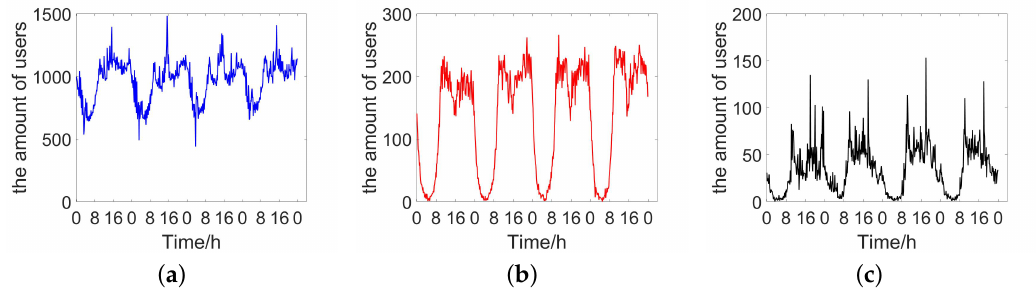
Figure 2. The amount of users extracted from three types datasets in a sample region. ( a ) The amount of users extracted from the mobility management signals in a sampl region; ( b ) The amount of users extracted from the call detail records in a sample region; ( c ) The amount of users extracted from the short message records in a sample region.